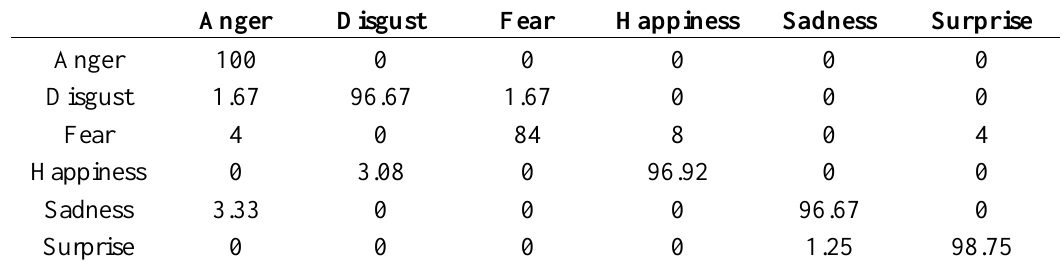
Table 5. Confusion matrix for facial expression recognition in percentages, using SVM with boosted features (200 AdaBoost selected features).